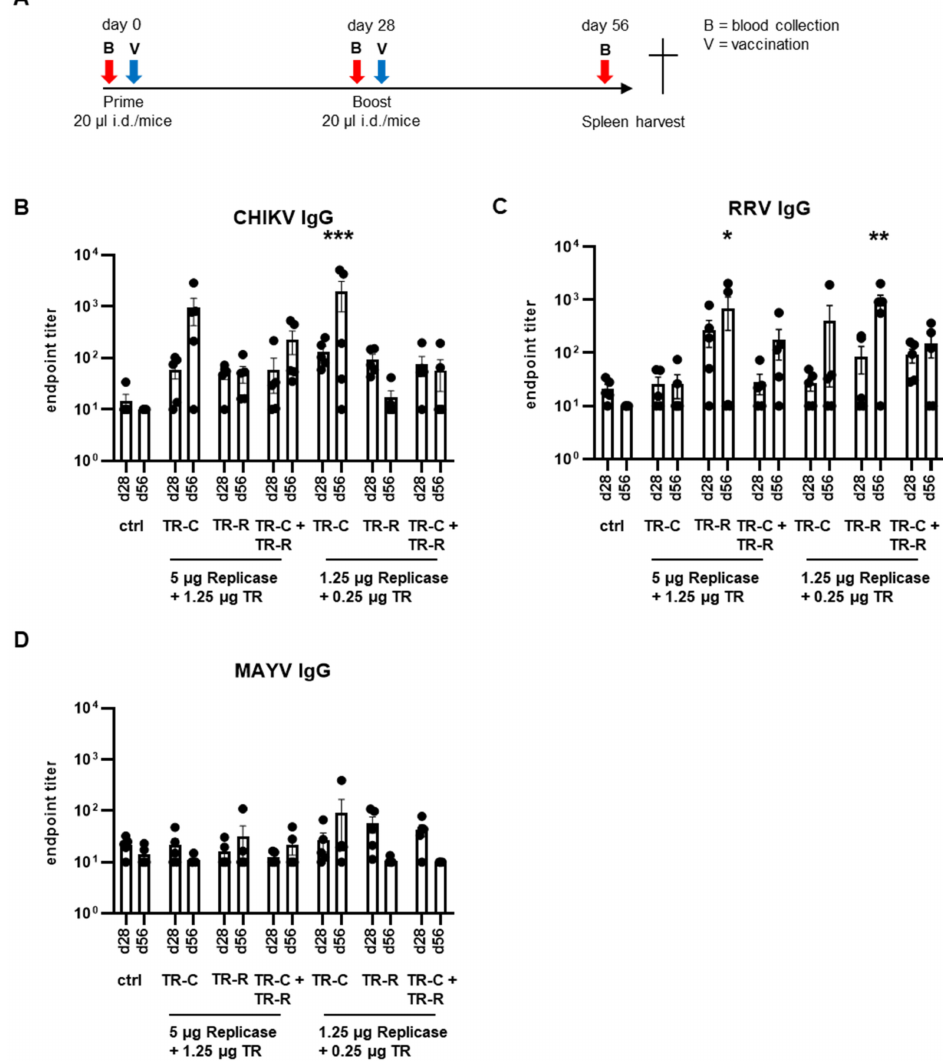
Figure 4. Humoral immune responses after taRNA vaccination. ( A ): Graphic illustration of the vacci- nation scheme. For vaccination, mice received the respective RNAs on day 0 and day 28 intradermally. As negative control, mice received PBS. For the analysis of humoral immune responses, blood was collected on day 28 and day 56. ( B ): CHIKV-binding, ( C ): RRV-binding, and ( D ): MAYV-binding IgG antibodies in mouse sera. Endpoint titers were calculated and were set to 10 for samples that were below the cutoff. The RNA doses and combinations are indicated. The mean values ± SEM of each group ( n = 5) are depicted. For statistical analysis, a two-way ANOVA with Dunnett’s multiple comparison post-test was performed (* p < 0.05; ** p < 0.01; *** p <